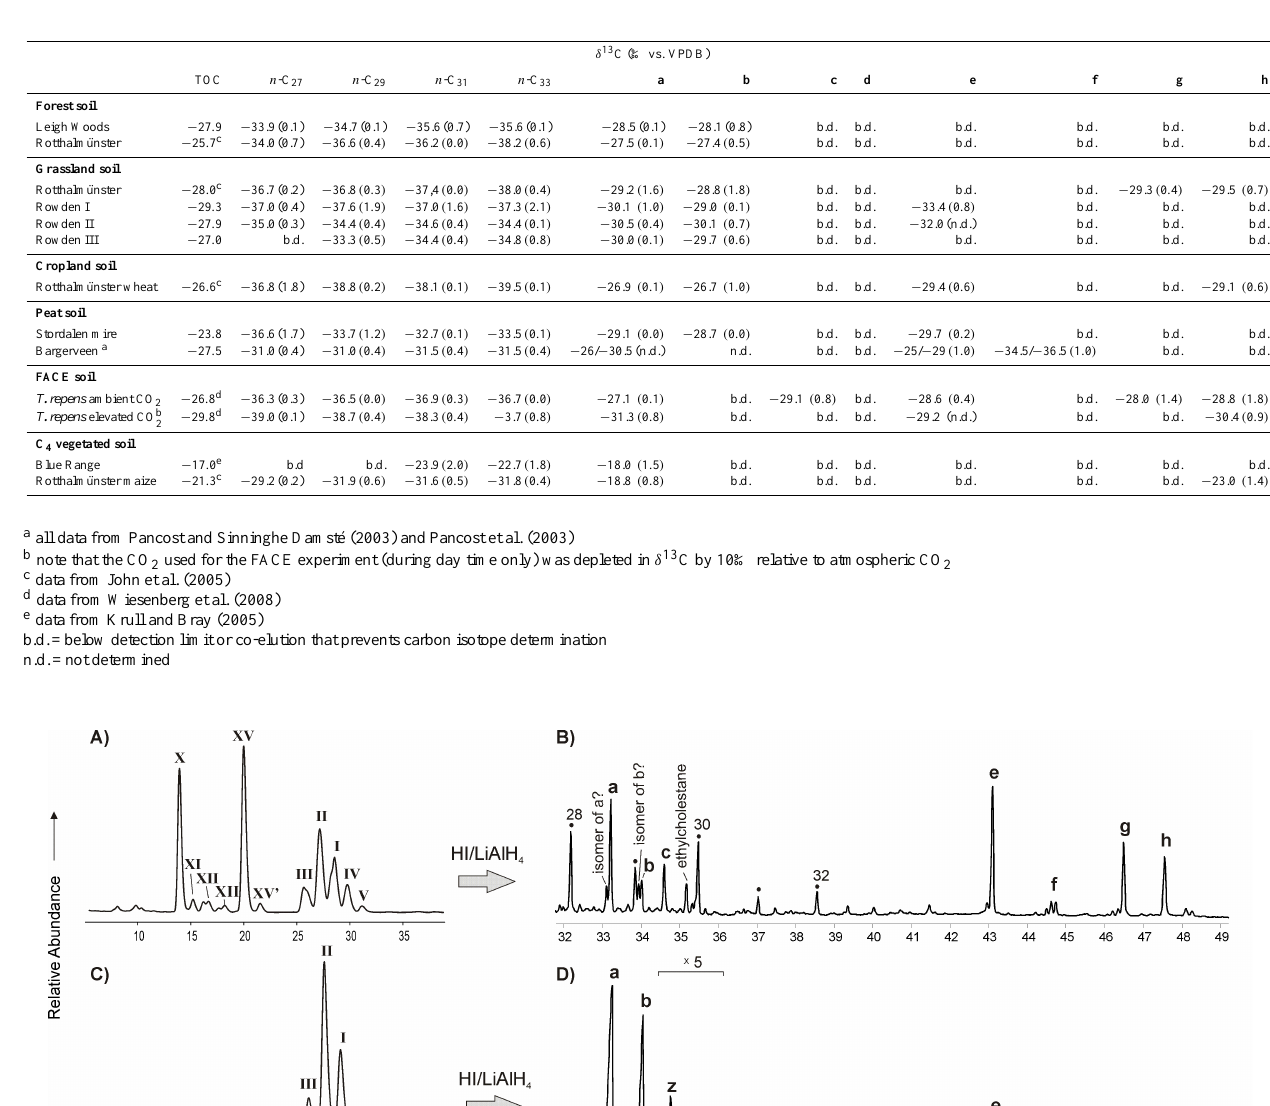
Table 2. Overview of the carbon isotopic composition (with standard deviation) of TOC, plant wax-derived odd-numbered n -alkanes and the different alkyl moieties released from the GDGTs by ether bond cleavage. The bold letters refer to the structures of the carbon chains drawn in Fig. 1.